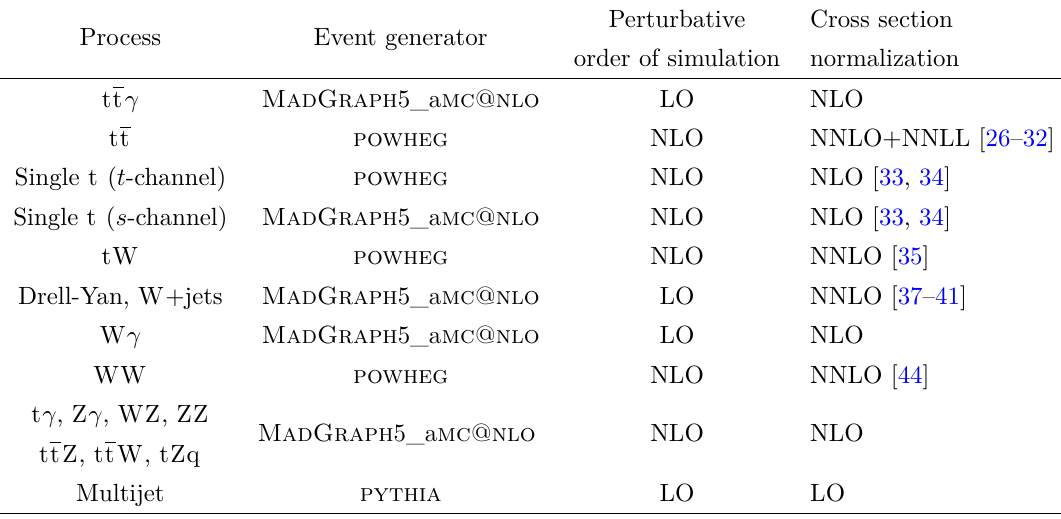
Table 1 . Event generator, perturbative order in QCD of the simulation, and perturbative order of the cross section normalization for each